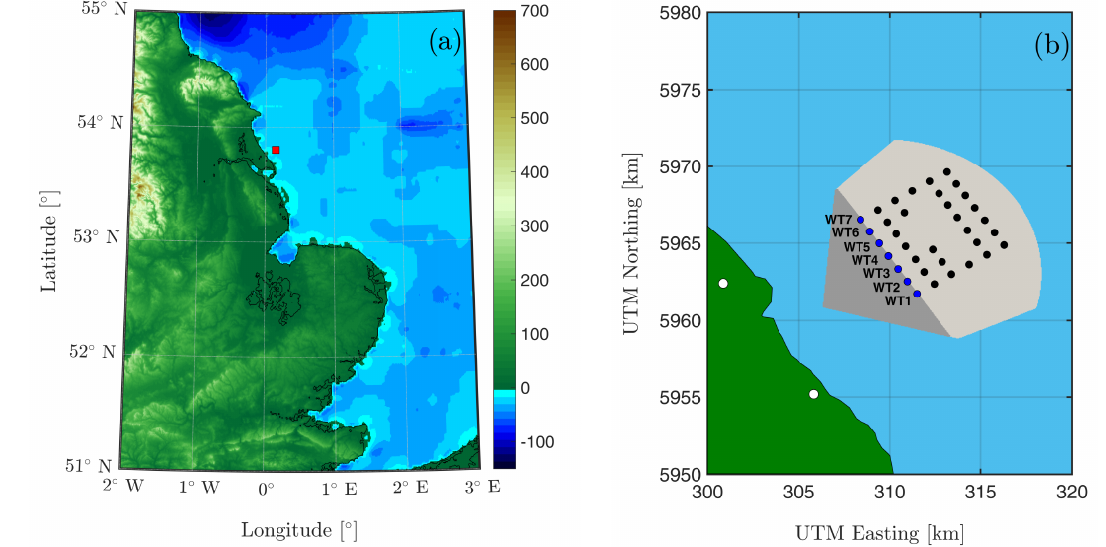
Figure 1. ( a ) location of the Westermost Rough wind farm ( ), 8km off the Holderness coast, in the North Sea. The colourbar indicates the height above mean sea level in meters; ( b ) layout of the wind farm showing the position of the radars ( ) and the wind turbines ( and ). Wind turbines used for this analysis ( ) are labeled. The dark and light gray shadowed areas indicate the overlapping dual-Doppler measurement area.